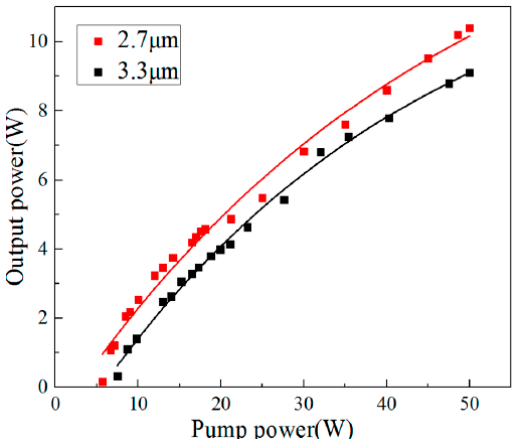
Figure 3. Output power of the module at 2.7 and 3.3 μ m as a function of incident pump power.